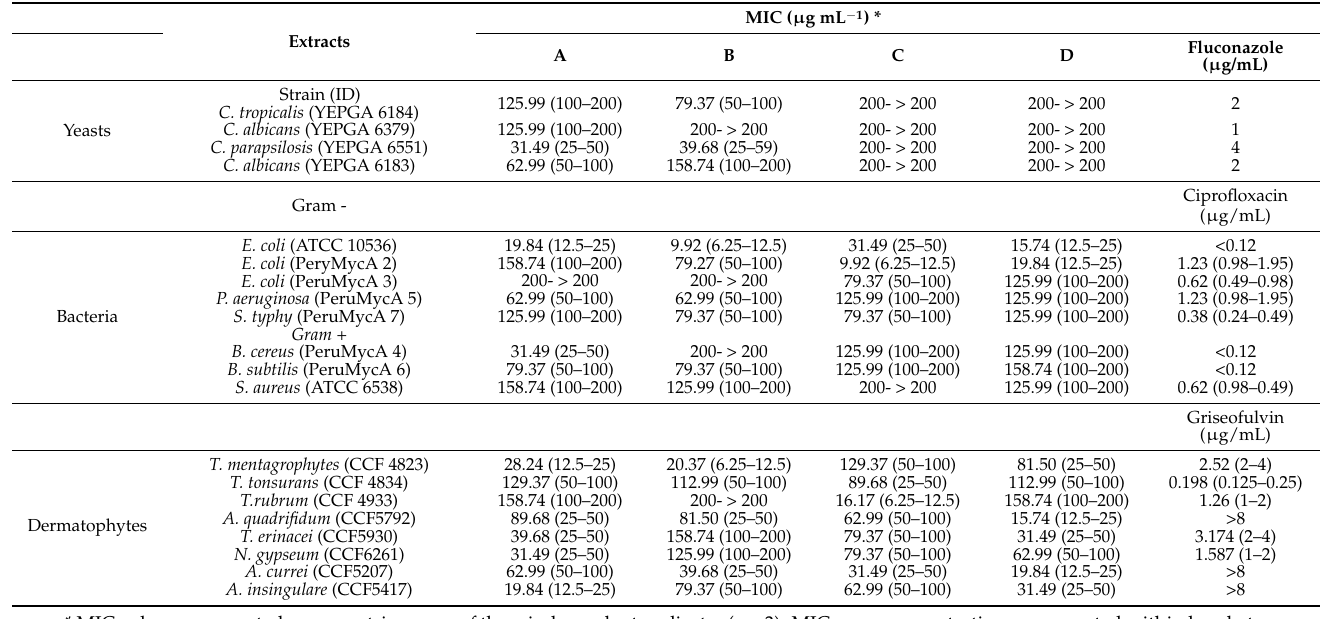
Table 2. Minimal inhibitory concentrations (MICs) of P. columbinus extracts against yeast, bacterial and dermatophytes strains.